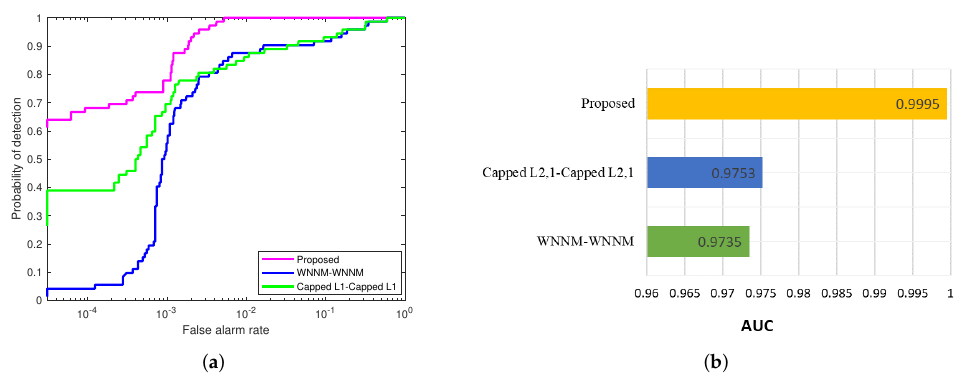
Figure 15. Visualizing ROC curves and AUC values in the SpecTIR dataset. ( a ) ROC curves. ( b ) AUC values.